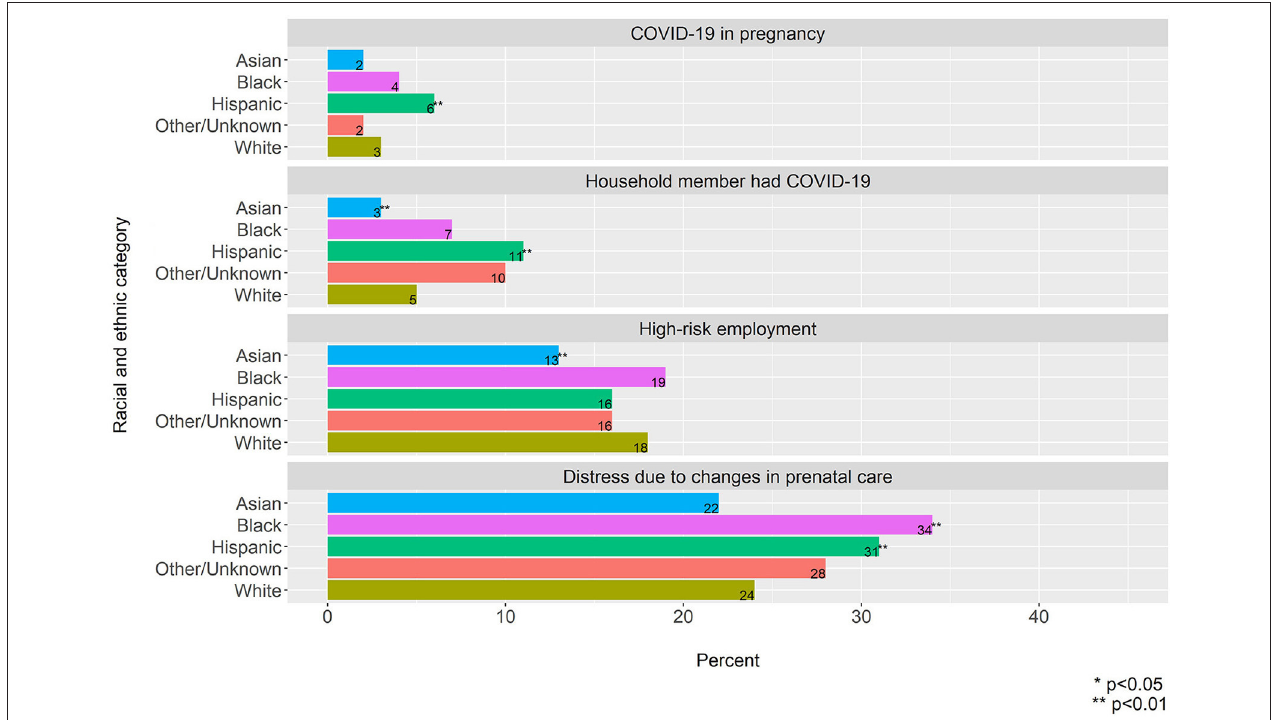
FIGURE 1 | Prevalence of health and healthcare stressors by racial and ethnic category.